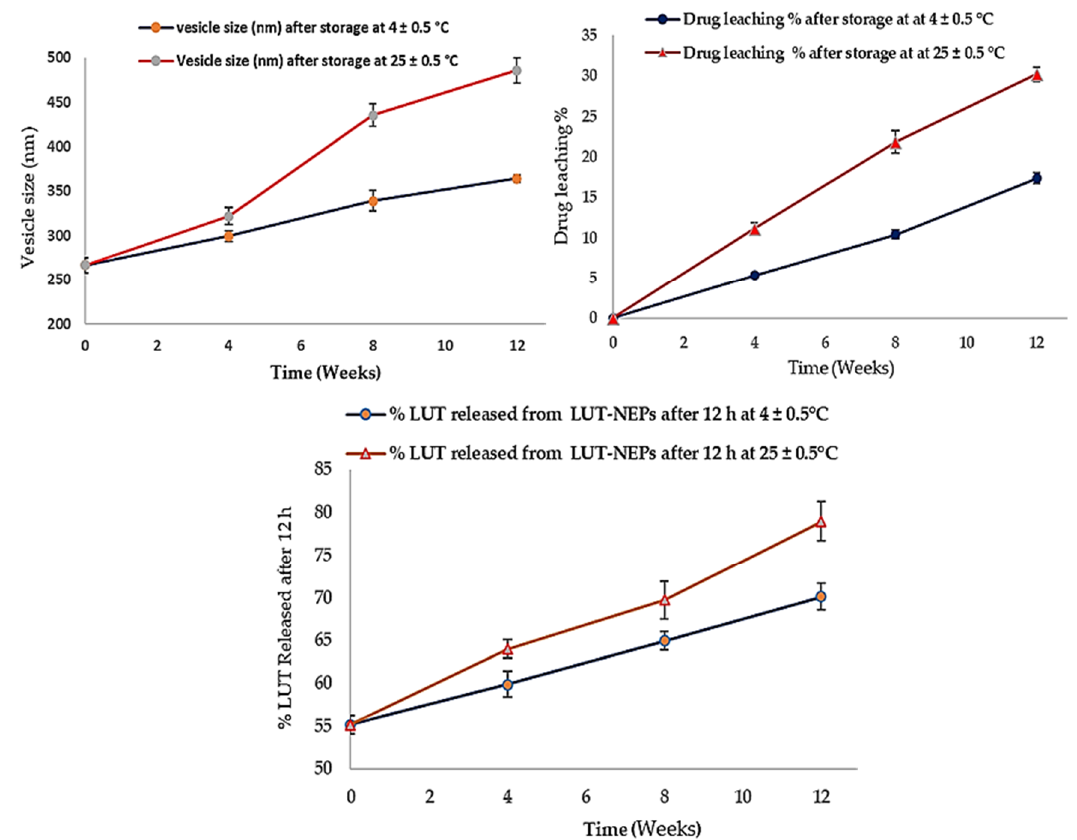
Figure 6. Stability profiles of the selected LUT-ENPs (F8) under storage at 4 °C and 25 °C for 12 weeks (mean ± S.D, n = 3).